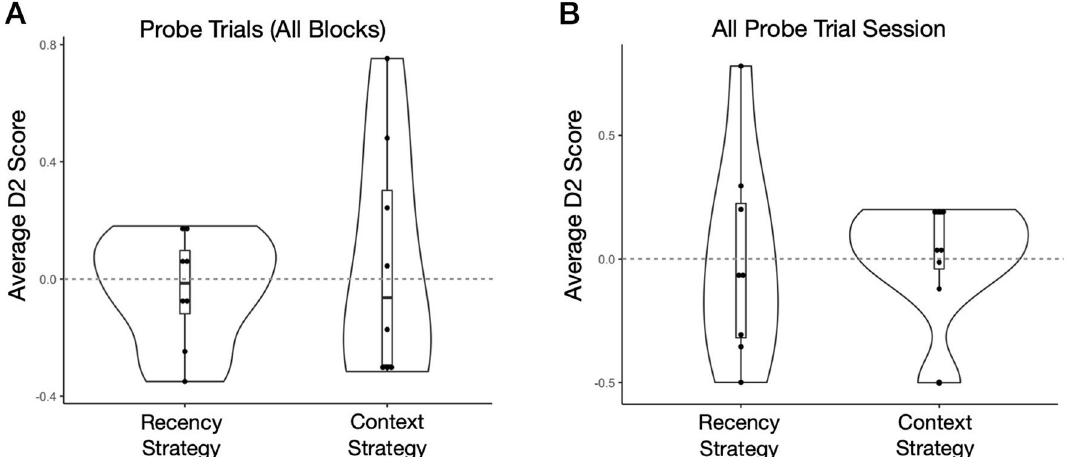
Figure 5. Probe trials across block 1–3 and the all probe trial session. ( A ) Probe trials (averaged across blocks 1–3): The average context D2 score (M = 0.05, SD = 0.40) and recency D2 score (M = − 0.04, SD = 0.20) did not differ from zero ( t (7) = 0.38, p = 0.72, d = 0.13; t (7) = − 0.53, p = 0.61, d = − 0.19; respectively). ( B ) All probe trials session: The average context D2 score (M = 0.001, SD = 0.23) and recency D2 score (M = − 0.002, SD = 0.42)